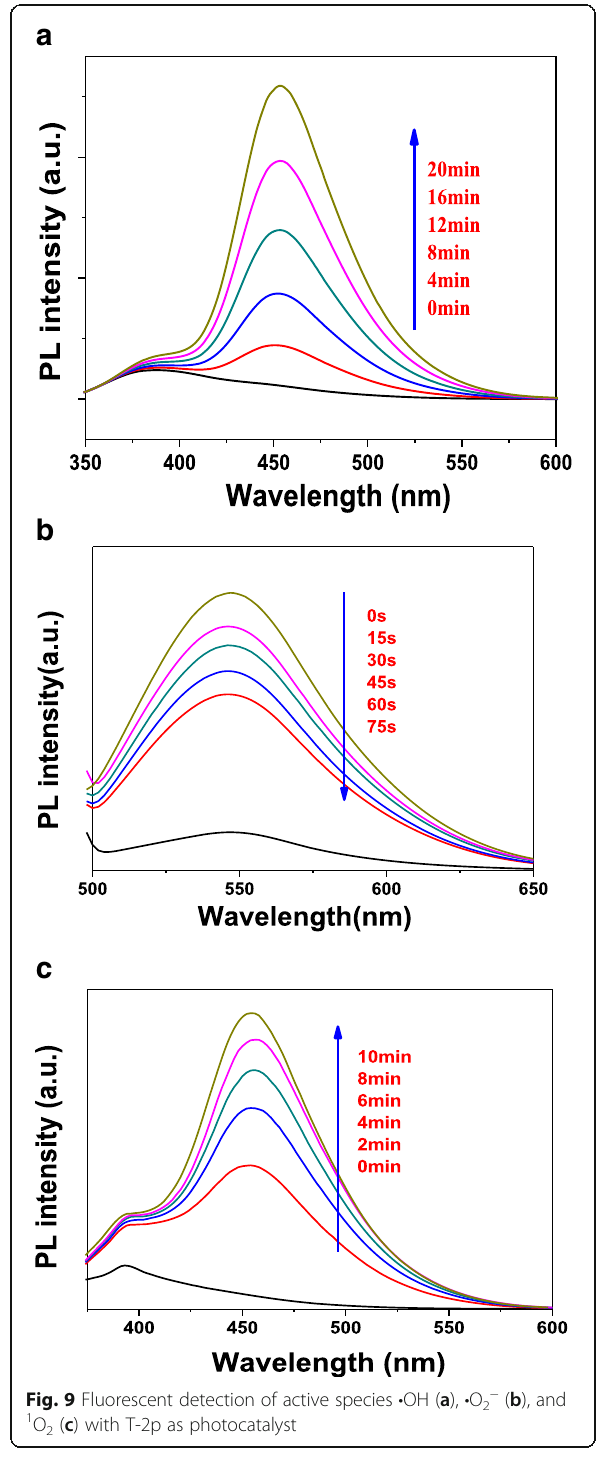
Fig. 9 Fluorescent detection of active species (cid:129) OH ( a ), (cid:129) O 2 − ( b ), and 1 O 2 ( c ) with T-2p as